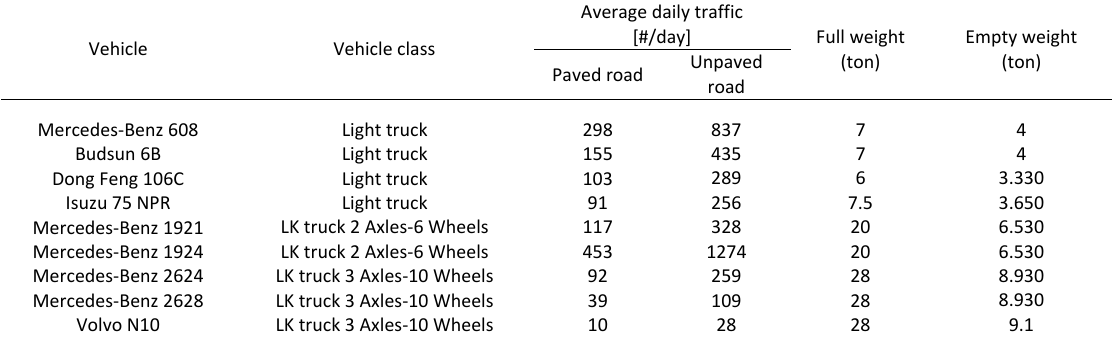
Table 1: Types of vehicles travelling on paved/unpaved roads in the mineral complex